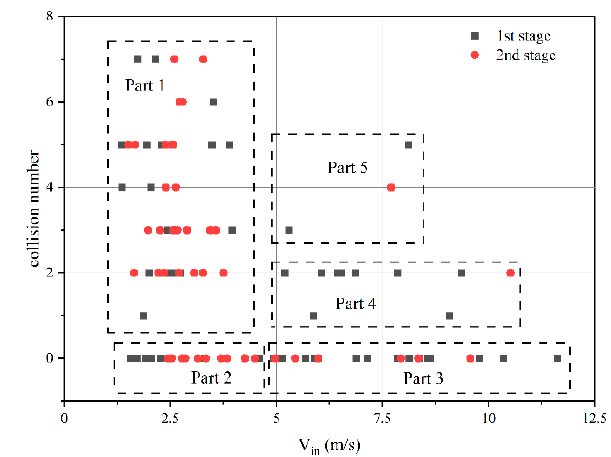
Figure 12. V in refers to the velocity of a particle after its last pass through the interface, and collision number refers to the number of collisions between a particle and the impeller blade after its last pass through the interface.